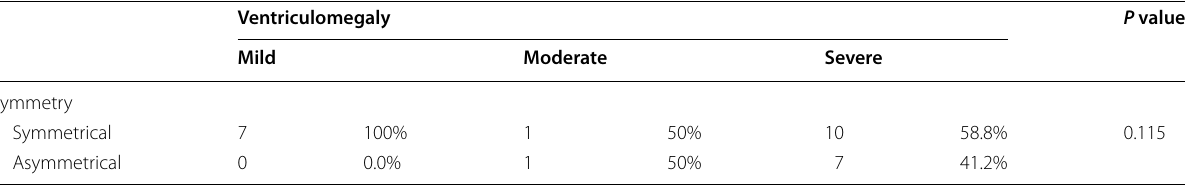
Table 4 Relation between ventricular symmetry and severity of ventriculomegaly